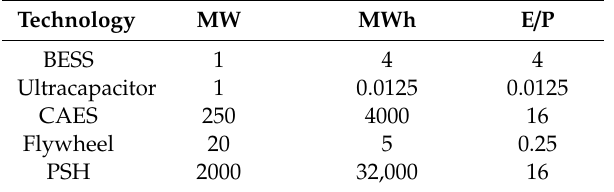
Table 4. Assumed energy, power, and energy-to-power ratios by technology